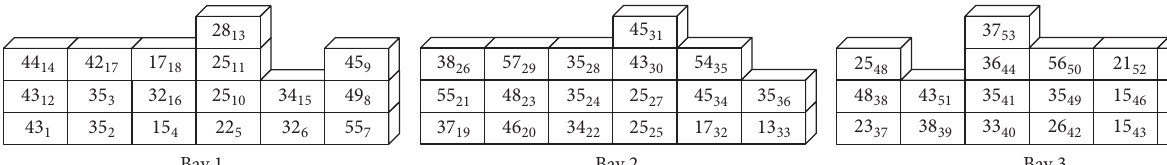
Figure 10: The piling state from bay 1 to bay 3 from first